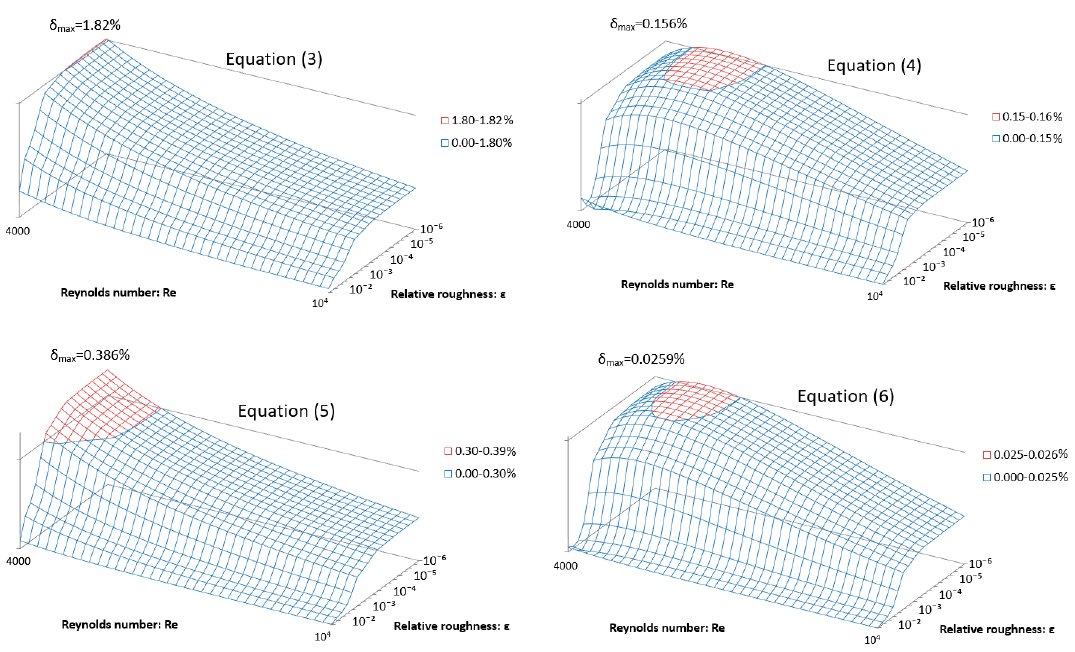
Figure 6. Additional analysis in MS Excel for the zone 4000 < Re < 10 4 .